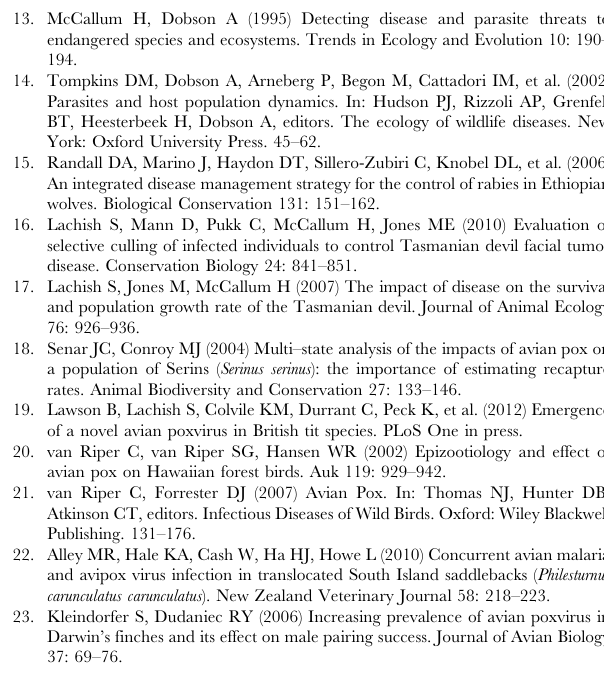
Table S2 Vital rates for healthy and disease individuals used in constructing age-structured population models. Table S3 Estimates of the reproductive performance of healthy and diseased parents from each of the two breeding